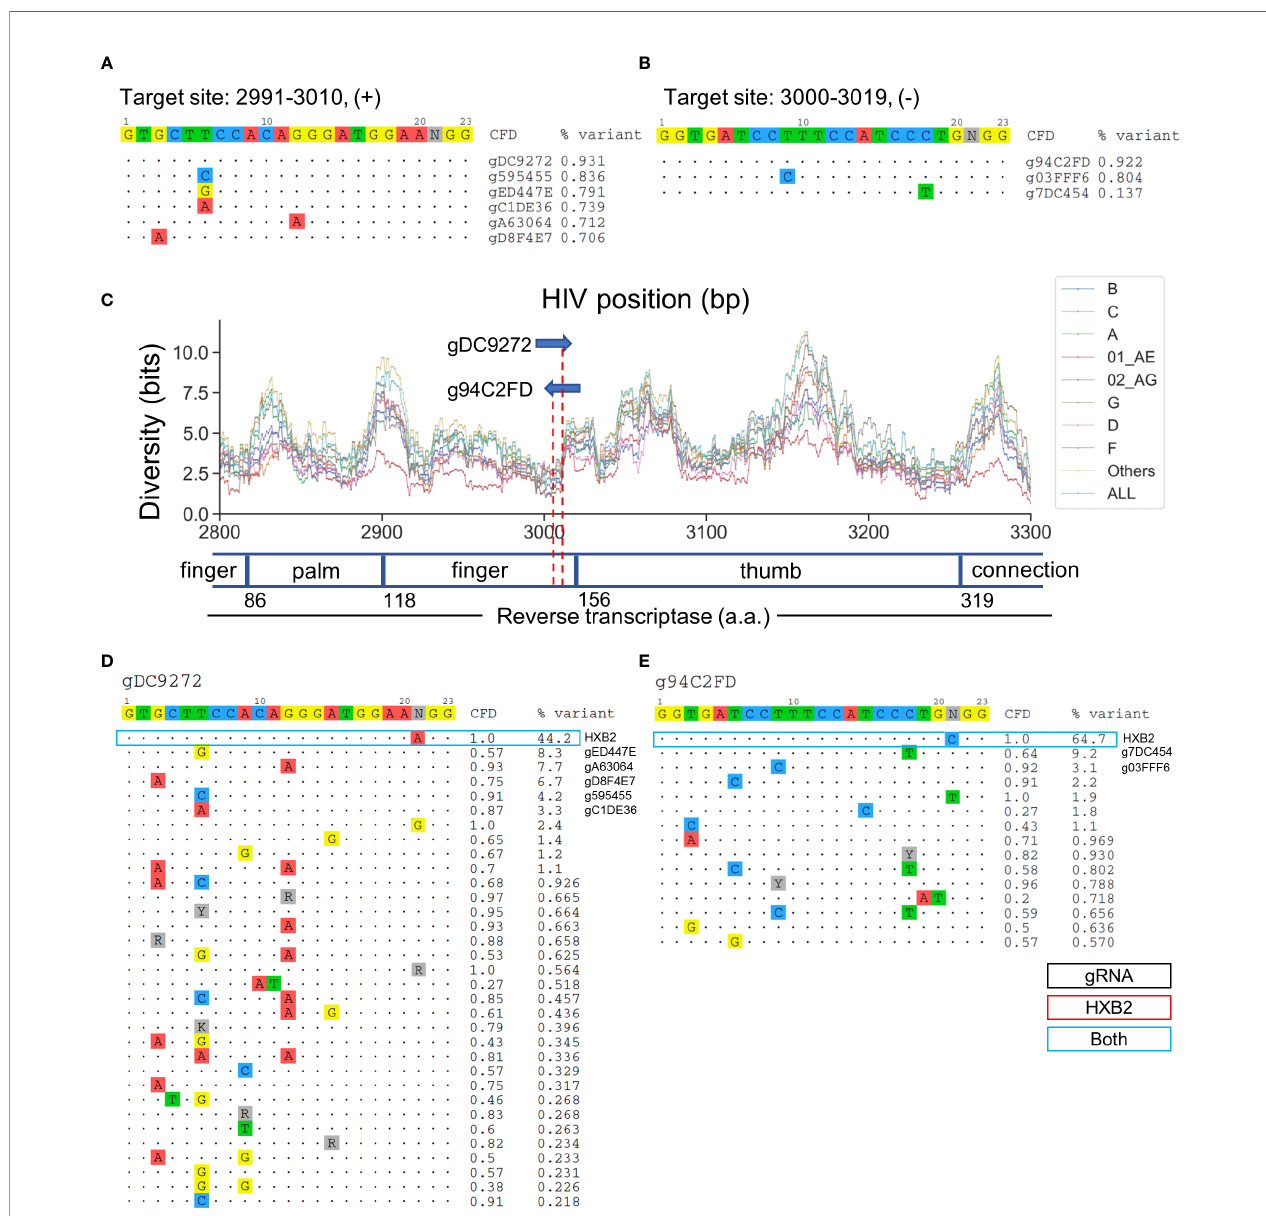
FIGURE 6 | Two lead gRNAs target critical dNTP binding domain in HIV RT protein that is responsible for effective reverse transcription. (A) All candidate gRNAs targeting position 2991-3010 (+) among 1,330 candidate gRNAs. (B) All candidate gRNAs targeting position 3000-3019 (+) among 1,330 candidate gRNAs. (C) The subtype-speci fi c sequence diversity across the HIV-1 genome between position 2800 and 3300. Major domains are shown in the open or closed blocks. The numbers next to domain names indicate the amino acid coordinate for reverse transcriptase. (D, E) Sequence variant pro fi les and corresponding CFD score between chosen gRNA and HIV-1 variants. “ HXB2 ” label next to the %variant represent the variant frequency of the sequence that possessed identical sequence compared with HXB2. The sequence variants labeled for gRNAs represent the gRNA contains the identical sequence with sequence